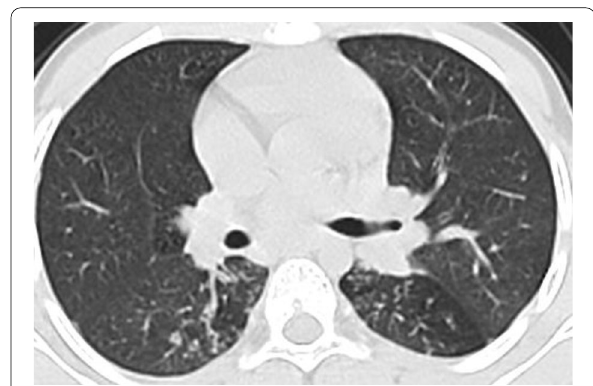
Fig. 8 A 56-year-old male with neuromuscular disorder complaining of dyspnea, cough and fever. HRCT of the chest in axial lung window image showing bilateral lower lobar apical segments centri-lobular and tree-in-bud nodules. The diagnosis of aspiration pneumonitis was made